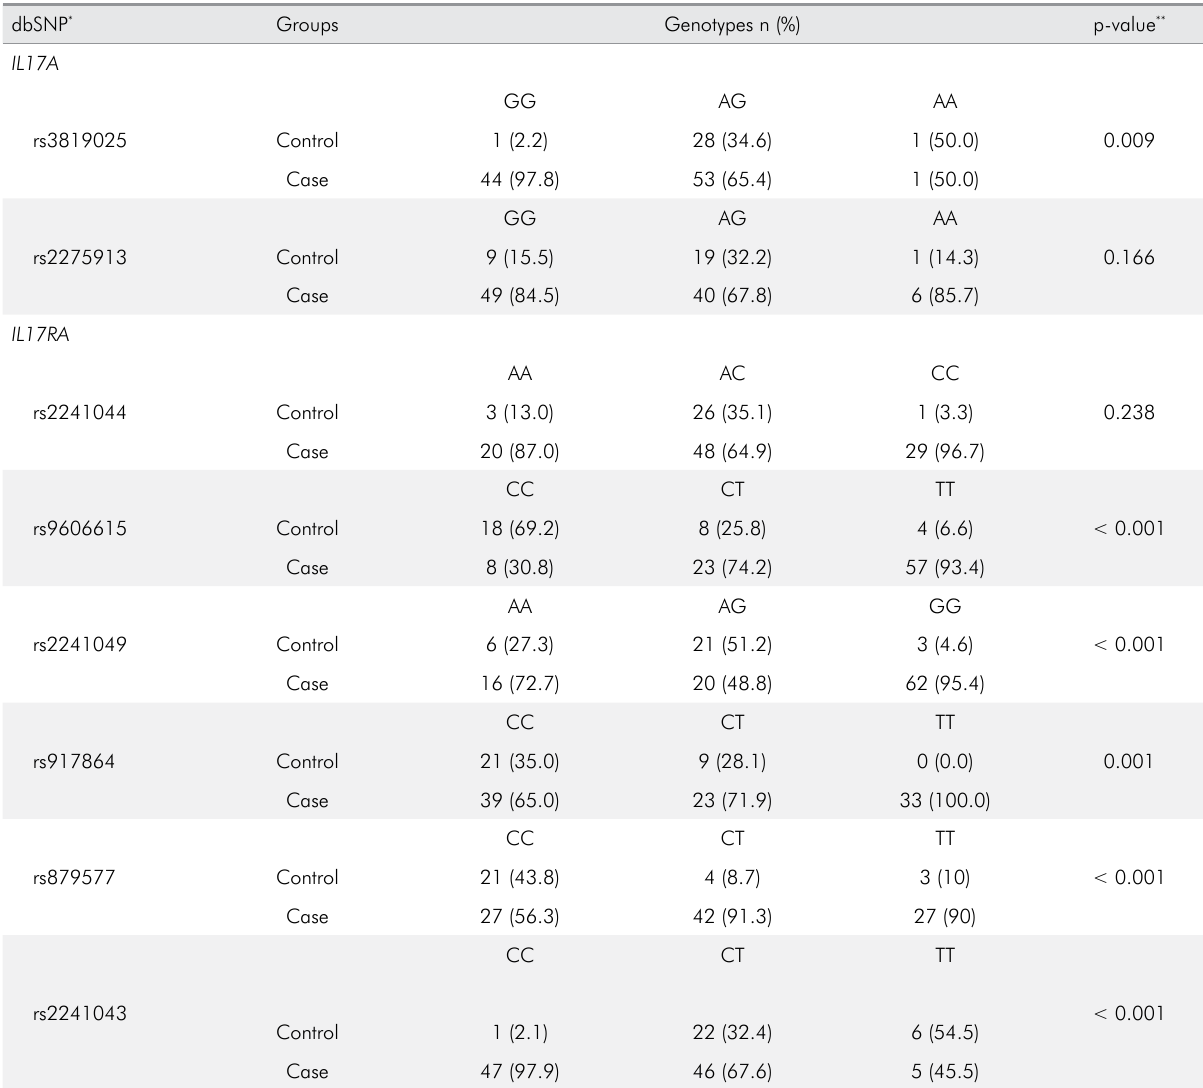
Table 2. Genotypic analysis in the additive model of the tag SNPs in the IL17 and IL17RA genes. dbSNP *